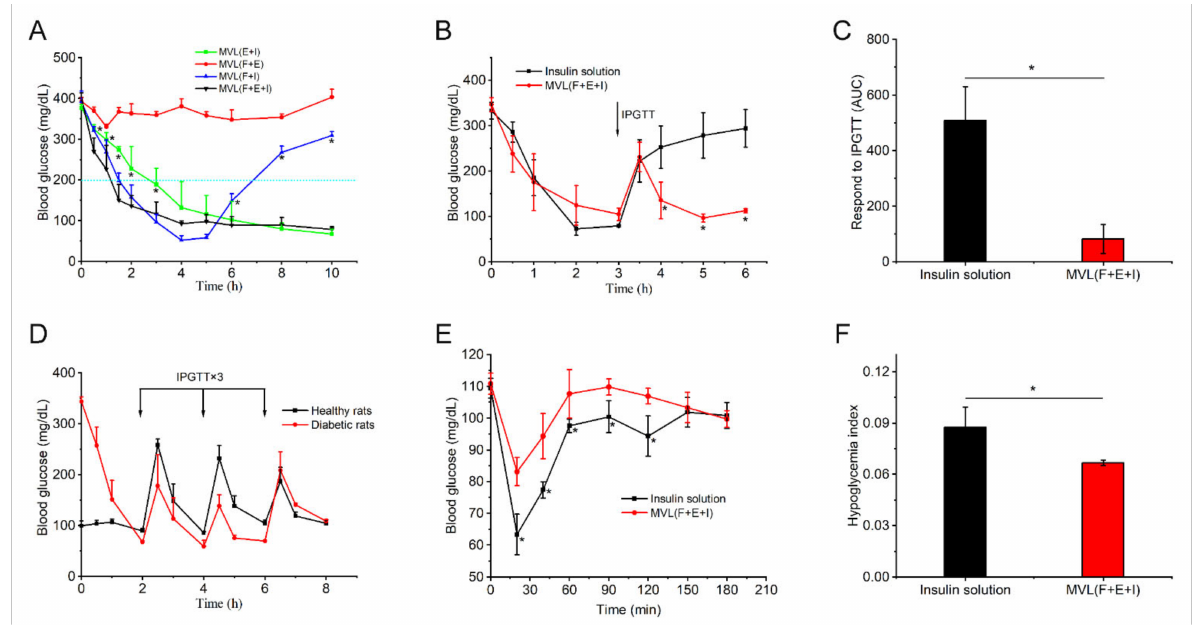
Figure 9. In vivo glucose regulation of MVLs on streptozotocin-induced diabetic rats: ( A ) BGLs of streptozotocin-induced diabetic rats subcutaneously administered MVL(E+I), MVL(F+E), MVL(F+I), and MVL(F+E+I). Statistical significance was determined by one-way ANOVA (* p < 0.05 for ad- ministration with MVL(F+E+I) compared with MVL(E+I) or MVL(F+I)). ( B ) Single IPGTT toward diabetic rats treated with MVL(F+E+I) and insulin solution. Statistical significance was evaluated by a two-tailed, unpaired t -test (* p < 0.05). ( C ) Responsiveness was calculated based on the area under the curve (AUC) from 3 to 6 h, with the baseline set at the 3 h blood glucose reading. Statistical significance was evaluated by a two-tailed, unpaired t -test (* p < 0.05). ( D ) Multiple IPGTTs toward diabetic rats treated with MVL(F+E+I) in comparison to the healthy rats. ( E ) Blood glucose changes in healthy rats treated with MVL(F+E+I) and insulin solution. Statistical significance was evaluated by a two-tailed, unpaired t -test (* p < 0.05). ( F ) Quantification of hypoglycemia index of MVL(F+E+I) and insulin solution. Statistical significance was evaluated by a two-tailed, unpaired t -test (* p < 0.05). Data are shown as mean ± SD ( n =